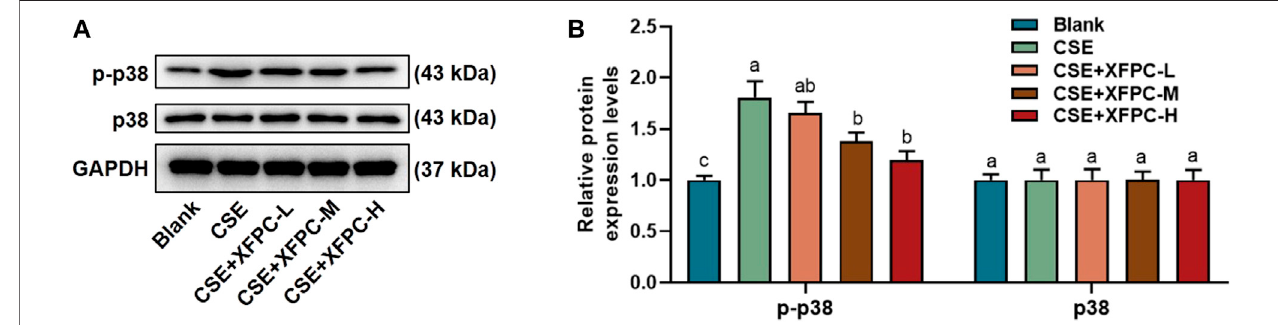
FIGURE 4 | XFPC could inhibit the level of p38 phosphorylation in CSE-HBE cell model. (A) The HBE cells were treated with CSE and different concentrations of XFPC. p38 and p-p38 proteins were detected by western bolt analysis. (B) Quanti fi cation of the levels of p38 and p-p38 in protein level. Lowercase letters indicate statisticallysigni fi cantdifferences( p < 0.05)accordingtoANOVAfollowedbyTukey ’ sHSDtest.XFPC,XuanfeiPingchuanCapsules;CSE,cigarettesmokeextract;HBE cells, human bronchial epithelial cells; p-p38,